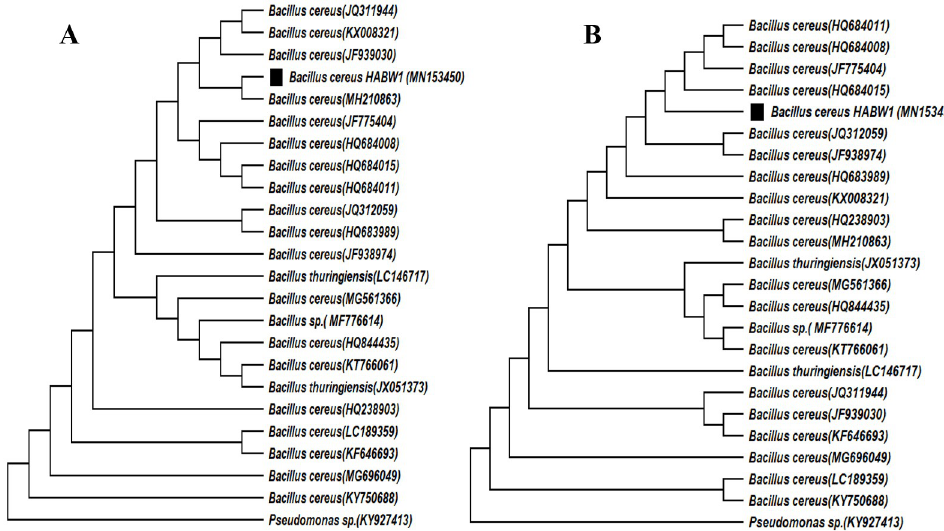
Fig 8. Phylogenetic tree (A: Neighbour-joining method, B: Maximum likelihood method) constructed based on 16S rRNA gene sequences of Bacillus cereus HABW1 (MN153450) and other related sequences retrieved from NCBI.